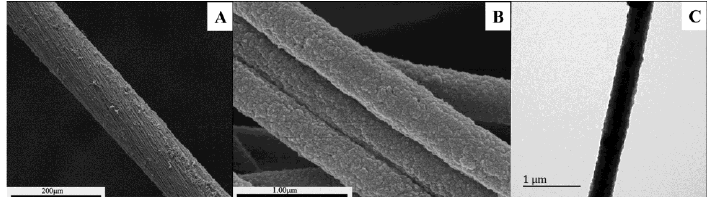
Figure 1. ( A ) Scanning electron microscopy (SEM) image of coaxial polypyrrole (PPy)-coated polyacrylonitrile (PAN) nanofiber yarn; ( B ) Field emission scanning electron microscopy (FESEM) image of aligned PPy–PAN nanofibers; ( C ) Transmission electron microscopy (TEM) image of PPy–PAN